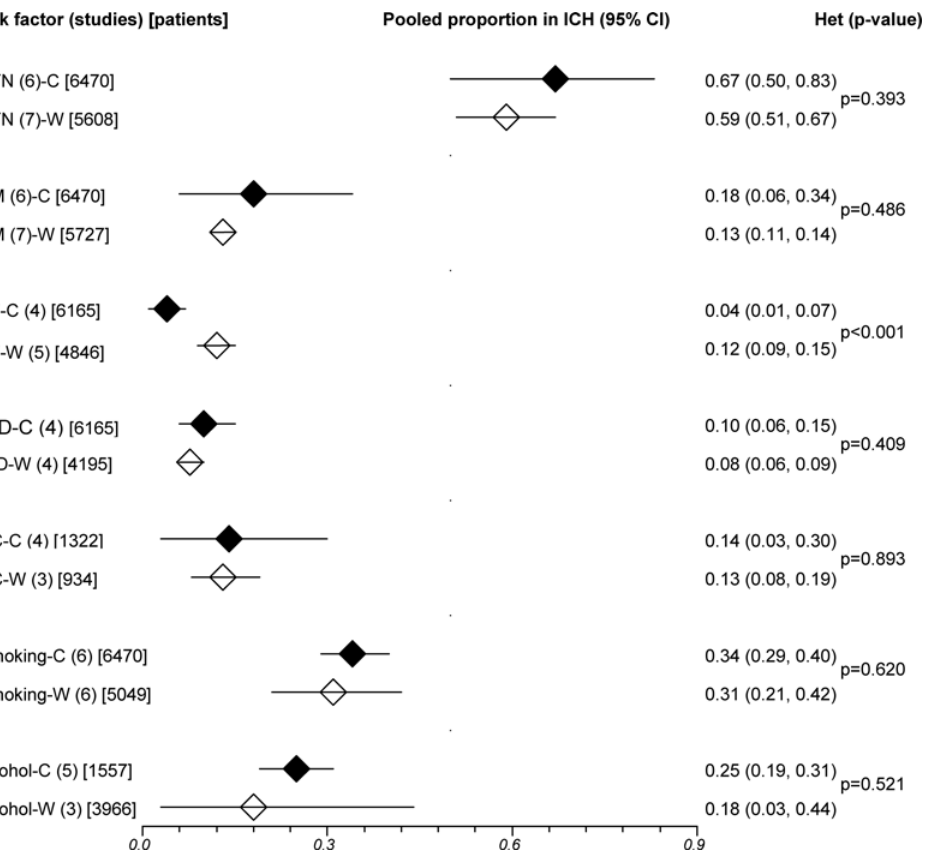
Fig 3. Pooled prevalence of risk factors in Chinese and white intracerebral hemorrhage. ICH = intracerebral hemorrhage; CI = confidence interval; Betw group het = between-group (ethnic) heterogeneity; C = Chinese; W = Whites; HTN = hypertension; DM = diabetes; AF = atrial fibrillation; IHD = ischemic heart disease; HC = hypercholesterolemia. Horizontal lines represent 95% CIs. Diamonds represent pooled proportions.